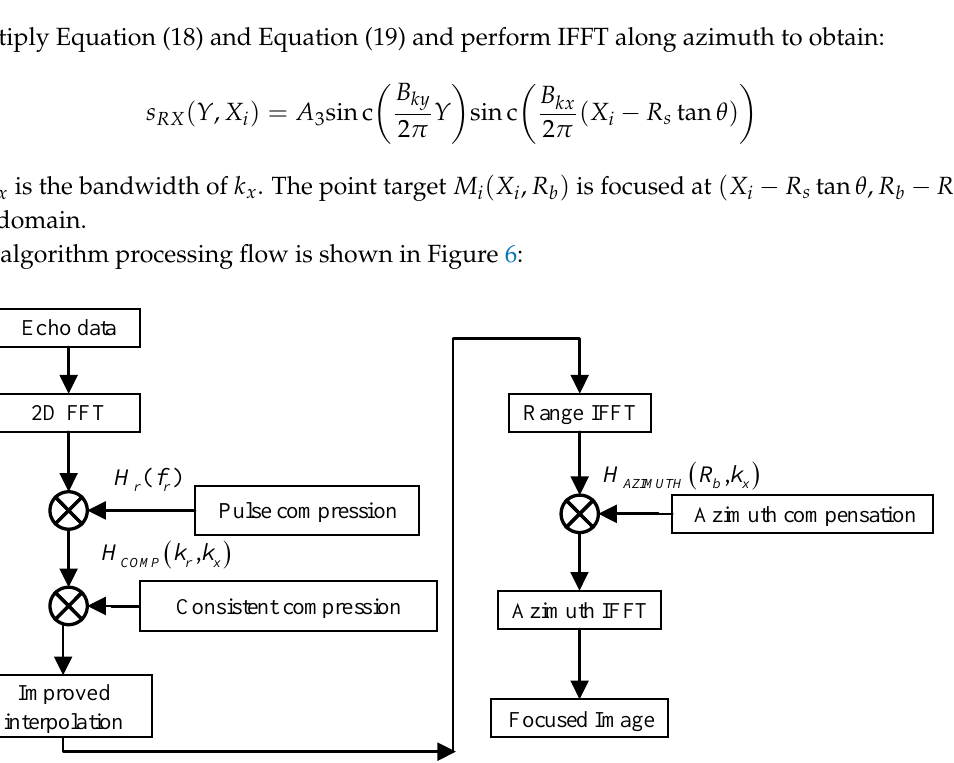
Figure 6. Multi-angle SAR algorithm flow